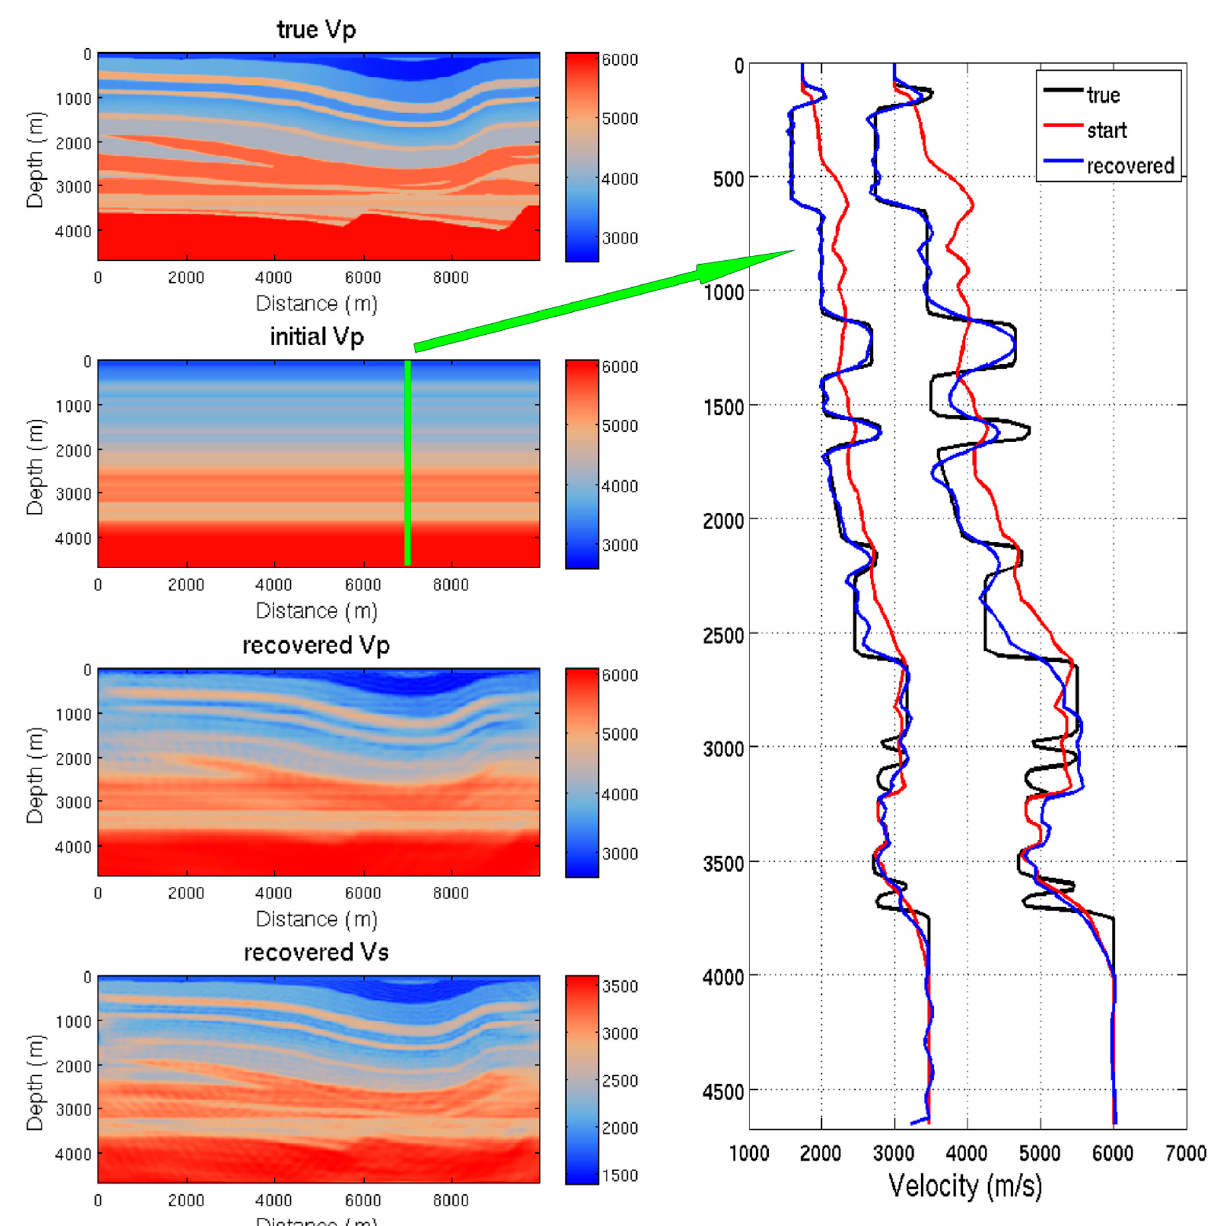
Figure 7. Elastic FWI in the modified formulation results. On the left (from top to bottom): true V p model, initial V p model, inverted V p and inverted V s distributions. On the right: vertical profiles at the distance 7000 m for V p − and V s − velocity distributions (black plot—correct velocity, red—initial and blue—inverted velocities).